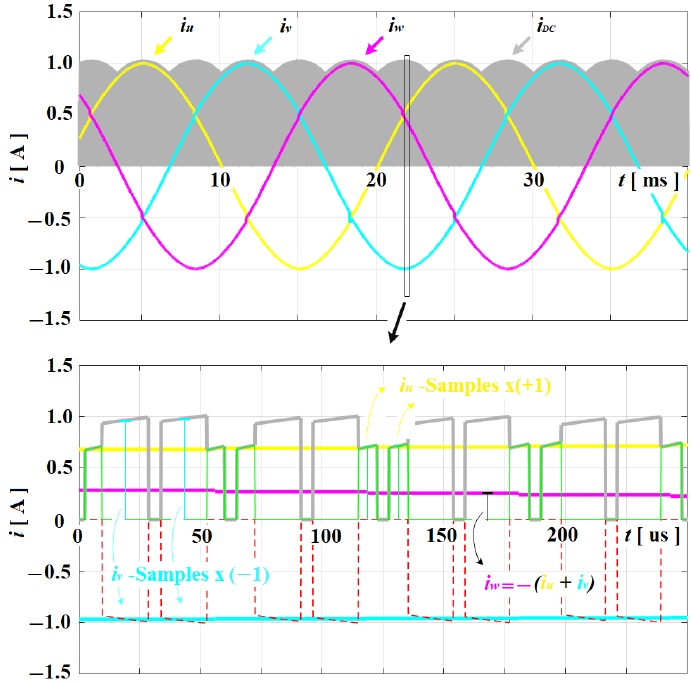
Figure 5. Current reconstruction. Table 5. Current measurement.